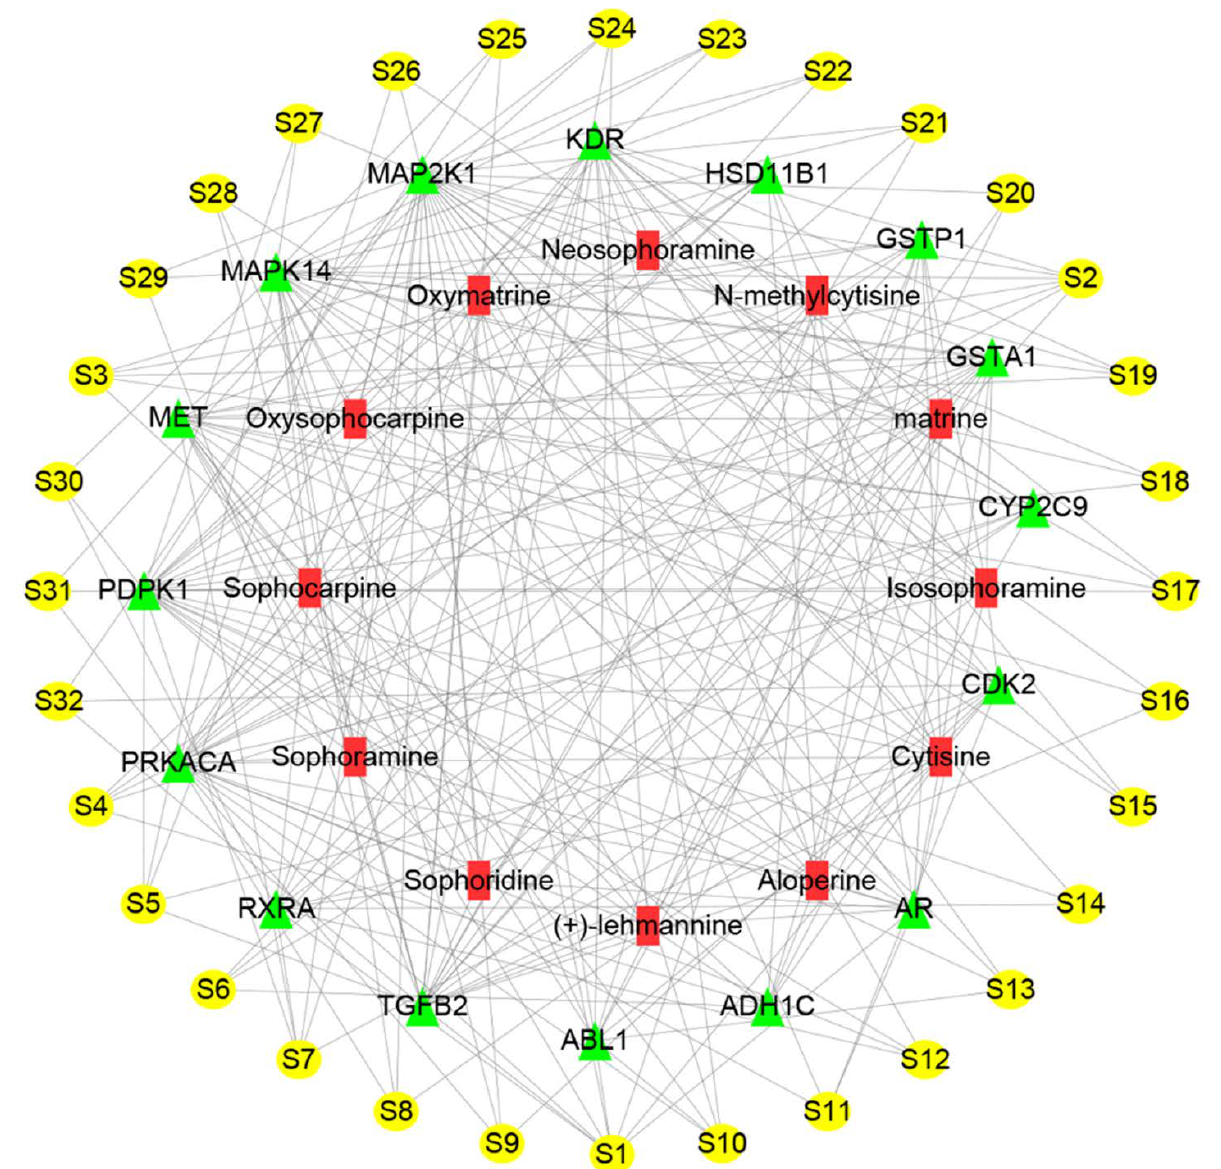
Figure 3. Compound-target-pathway network. The red oblong, green triangles, and yellow circles correspond to SA, target proteins, and pathways, respectively. This network comprises 60 nodes (12 candidate compounds and 16 potential targets) and 262 edges (compound–target interactions).